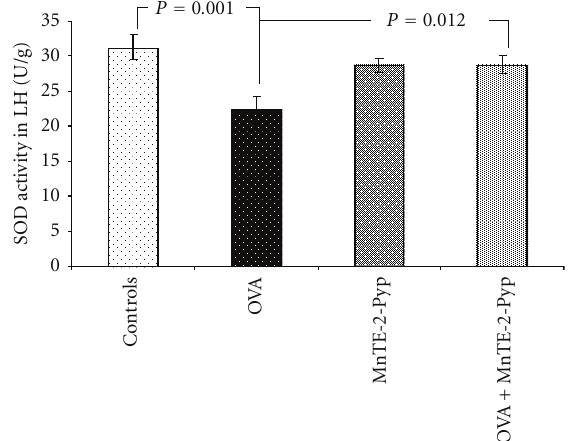
Figure 1: Activity of superoxide dismutase in lung homogenate. Each point represents the mean ± SEM for six